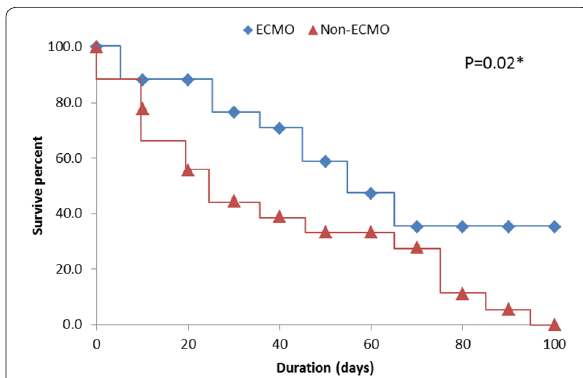
Fig. 1 Kaplan–Meier survival curves of the two studied groups. P value for log‑rank test is